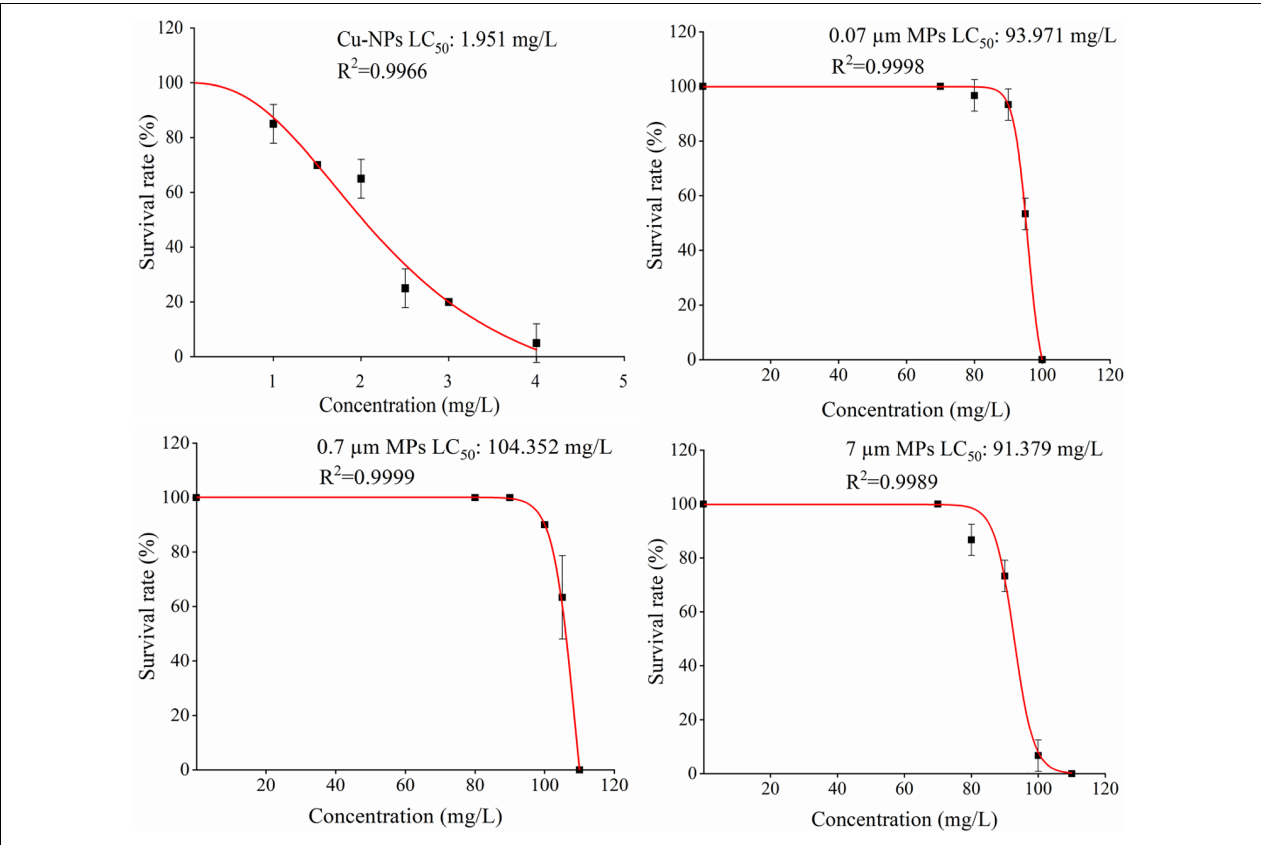
FIGURE 2 | Survival rate curve of zebrafish exposed to Cu-NPs, 0.07 µ m MPs, 0.7 µ m MPs and 7 µ m MPs for 96